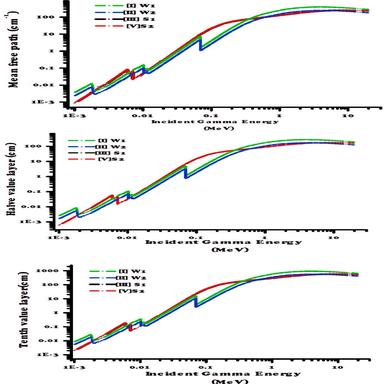
Mean free path, half and tenth value layers the W1, W2, S1 and S2 investigated alloys against gamma ray.